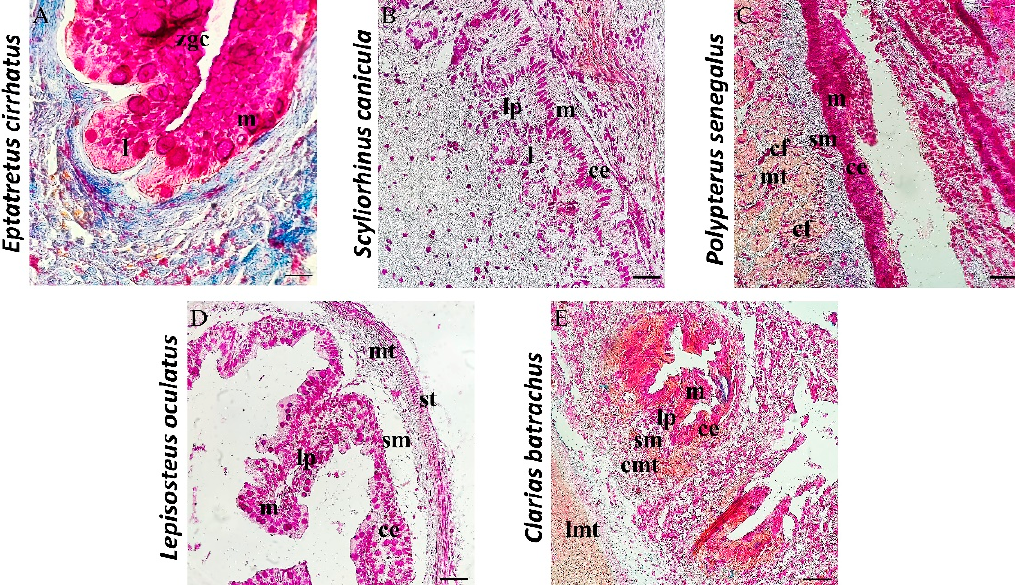
Figure 3. Sections of intestine stained with Mallory Trichrome, 40x, scale bars 40 µm. ( A ) Mucosa (m), submucosa (sm), and Muscolaris serosa (ms) are the three layers of the gut of Eptatretus cirrhatus . The mucosa is arranged in zigzag ridges, with evident zimogenous cells (zgc), and scattered immune cells (l). ( B ) The intestine of Scyliorhinus canicula is separated into mucosa, submucosa, mus- colaris, and serosa. The mucosa is organized in folds that are virtually obliquely oriented. A colum- nar epithelium (ce) of enterocytes forms the mucous layer (m). Scattered immune cells (l) are evident in lamina propria (lp). ( C ) The gut of Polypterus senegalus presents a mucosa (m) with columnar epithelium (ce), submucosa (sm), muscolaris (mt), and serosa (st). The mucous layer of the intestine shows goblet cells and columnar epithelial cells (ce). The thickness of the submucosa contains col- lagen fibers (cfs). ( D ) There are four strata in the gut of Lepisosteus oculatus : mucosa (m), submucosa (sm), muscolaris (st), and serosa (st). In the mucosa, longitudinal folds and a columnar epithelium (ce) accompanied by goblet cells can be seen. ( E ) The intestine of Clarias batrachus morphologically shows four laminae : mucosa (m), submucosa (sm), muscolaris (mt), and serosa (st). The mucosa of the intestine is folded and has a columnar epithelium (ce) comprising enterocytes and mucipar caliciform cells. Muscularis is organized in longitudinal (lmt) and circular (cmt). Figure 4. Sections of intestine stained with AB/PAS, 40x, scale bar 40 µm. ( A ) In the intestine of Eptatretus cirrhatus , mucous cells according to the type of secretion (acid in blue, neutral in magenta, and mixed in purple) can be distinguished. Staining highlights several mucous cells with an ovoid shape in blue (*) with acidophilic secretion. ( B ) Two mucous cell populations, neutral mucous (ma- genta) (arrows) and mixed secretion mucous cells (neutral and acid) (purple) (arrowheads), were